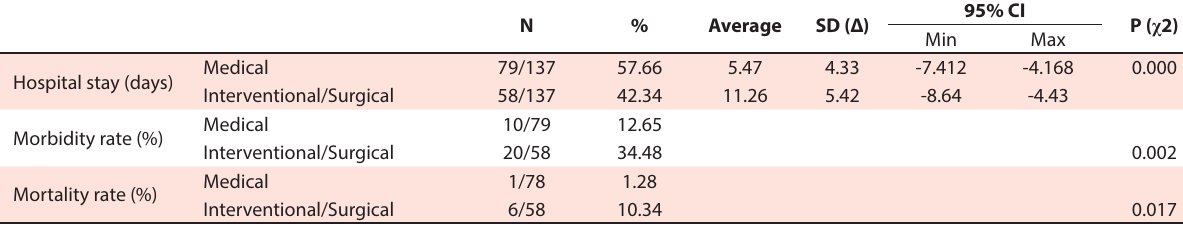
Table 3. Independent samples t test (medical and interventional/surgical treatment vs outcome)